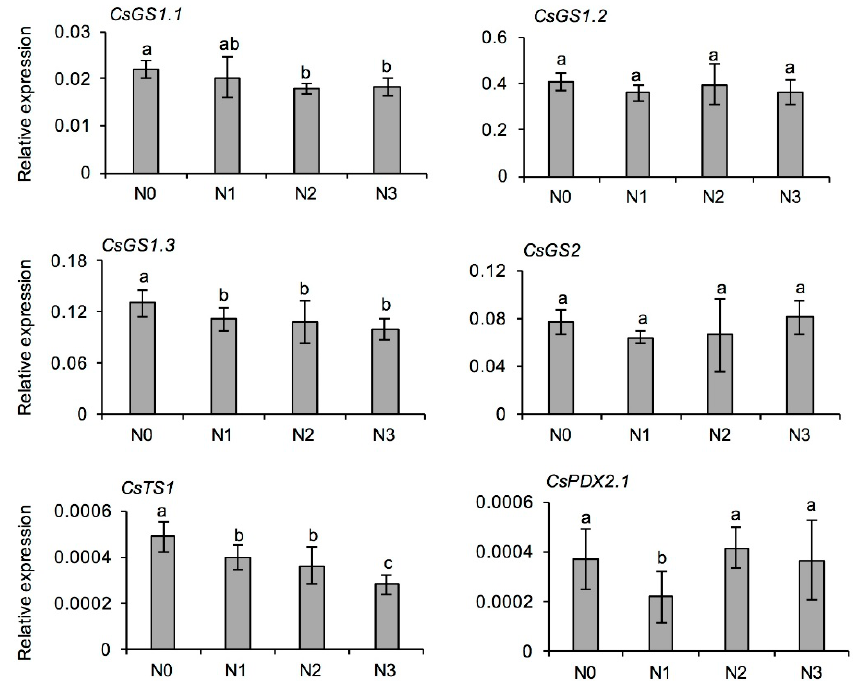
Figure 2. Effects of long-term nitrogen application on the expression of characteristic genes for L -theanine synthesis and degradation in fresh tea leaves collected in spring. TS : L -theanine synthase ; GS : L -glutamine synthase ; PDX : pyridoxal 5 ′ -phosphate synthase subunit . The nitrogen application treatments indicate N0: 0 N kg/hm 2 ; N1: 112.5 N kg/hm 2 ; N2: 225 N kg/hm 2 ; N3: 450 N kg/hm 2 , respectively. Values followed by different letters (a–c) mean significant at the 5% level among different treatments.